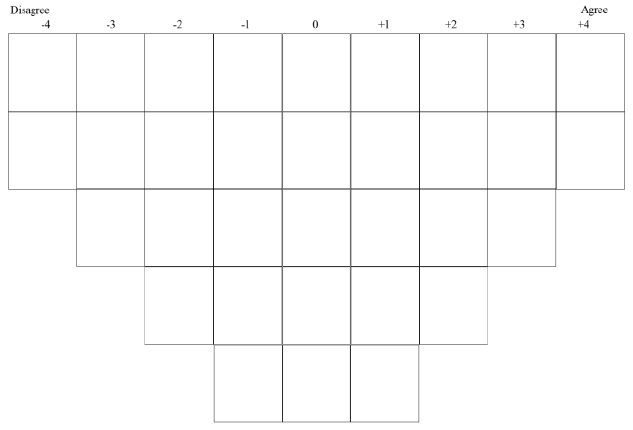
Figure 2. Q-methodology grid .